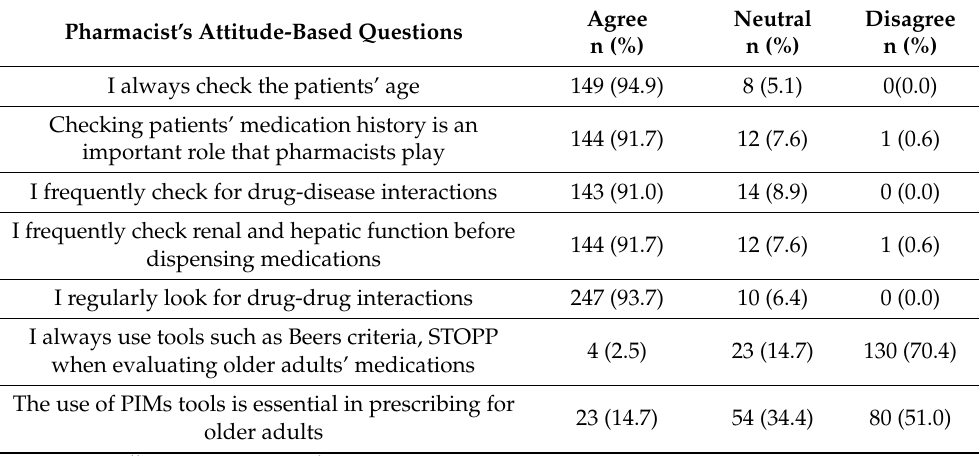
Table 4. Pharmacists’ attitude towards the procedures to follow when dispensing prescriptions for older